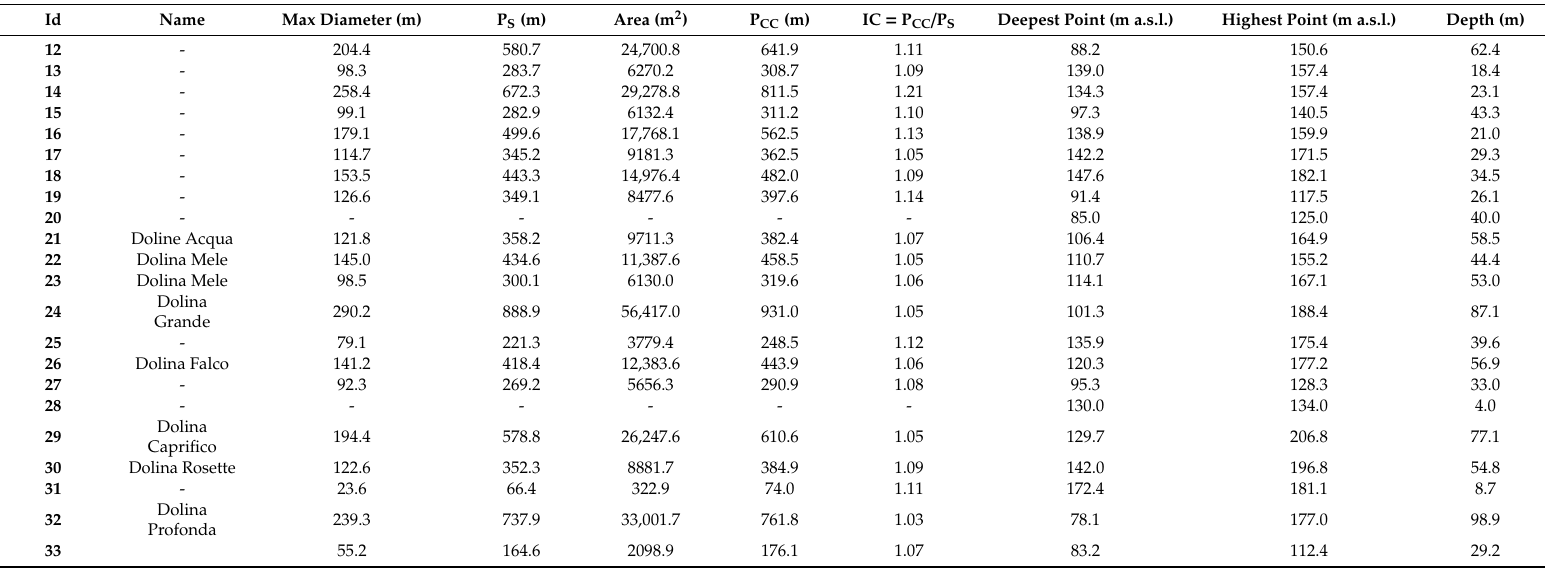
Table 2. Main features of the sinkholes of the Montepugliano relief. The parameter P S , P CC , and IC have the same meaning as reported in Table